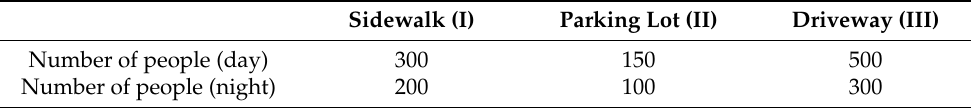
Table 1. Detailed information on the population for the F–N curve.